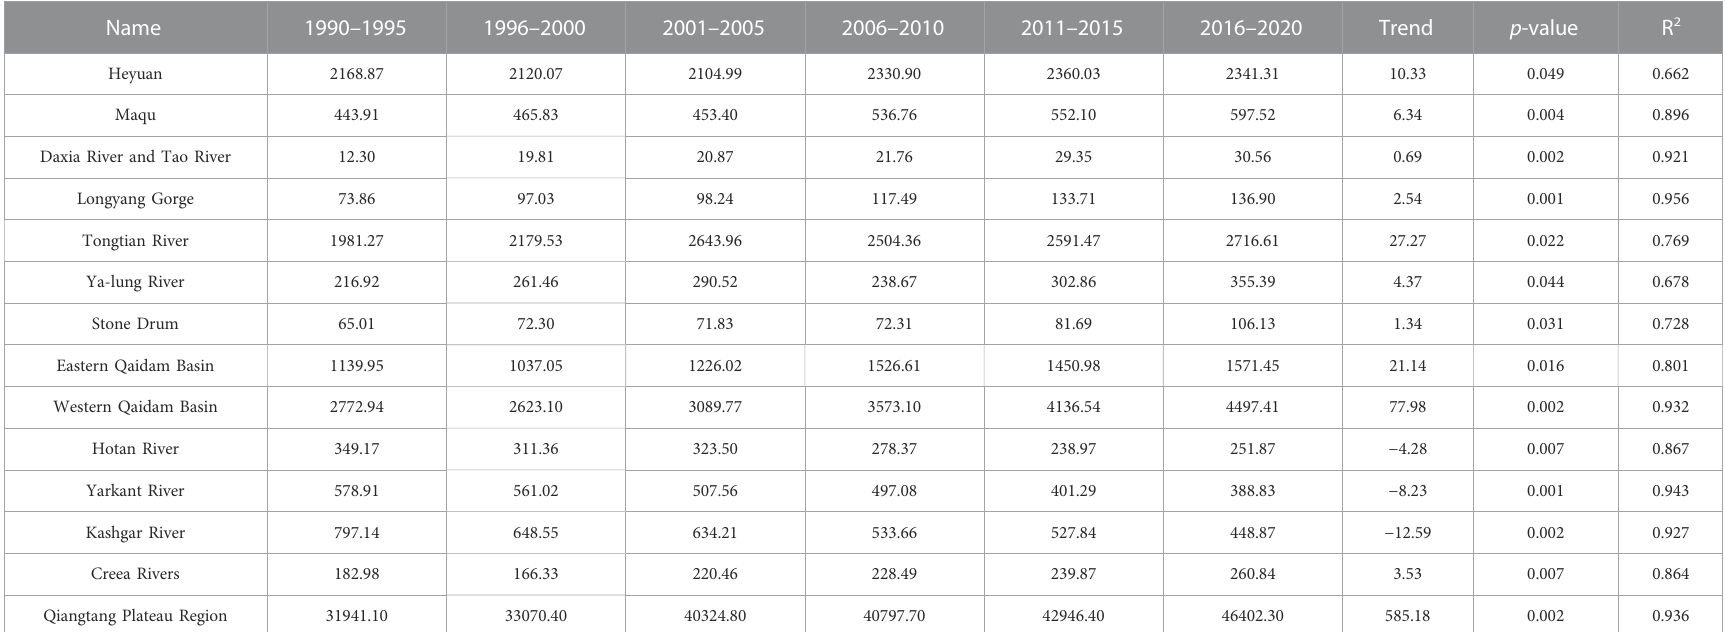
TABLE 5 Watersheds with signi fi cant changes in surface water area ( km 2 , Trend: km 2 yr -1 ) .